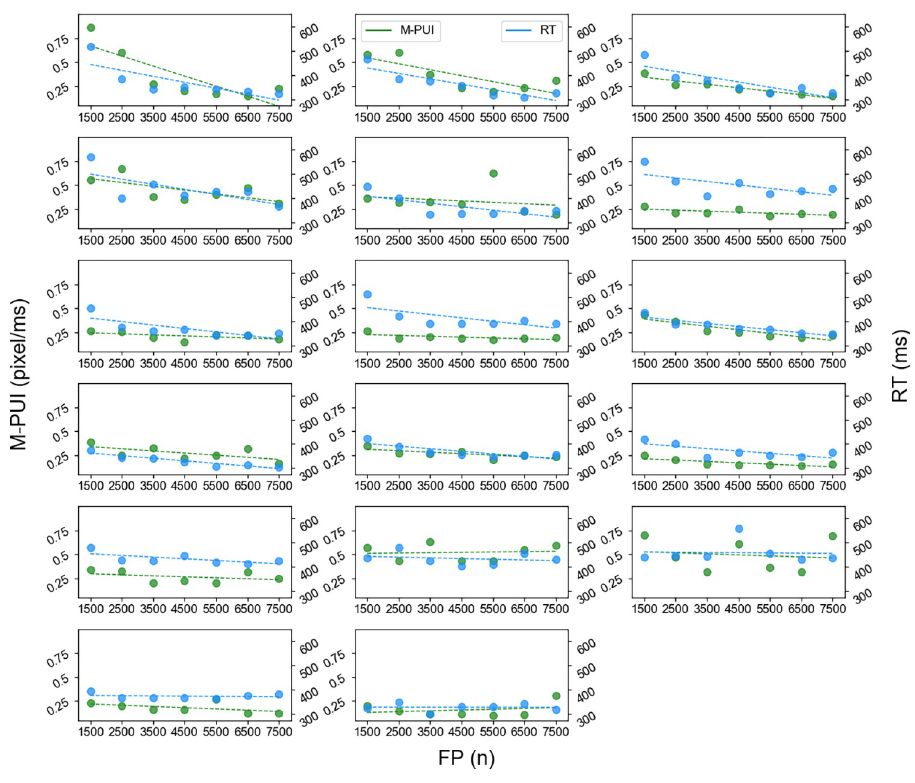
Fig 2. RT and M-PUI for each FP